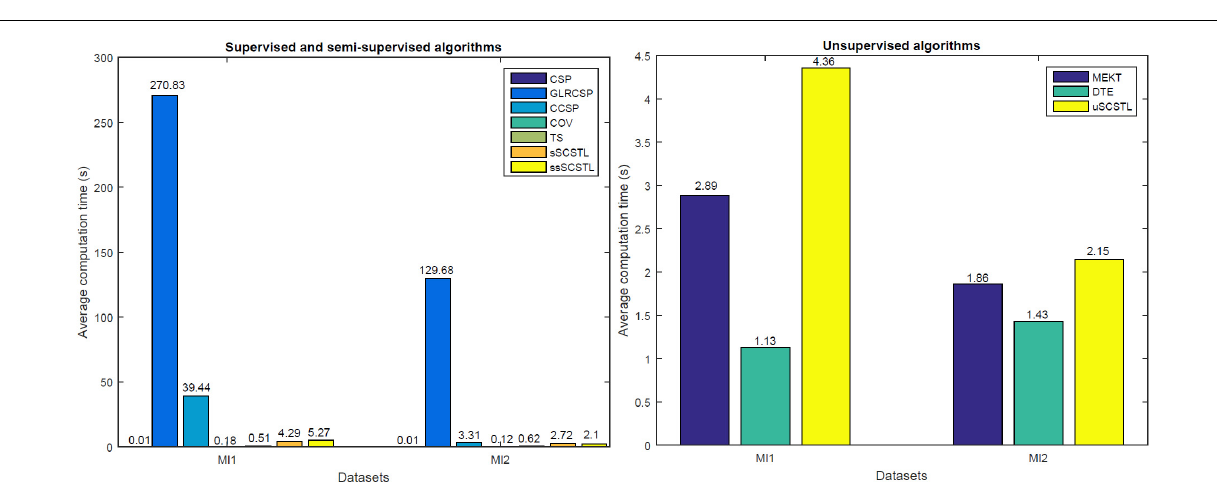
FIGURE 9 | Computation time comparison of different